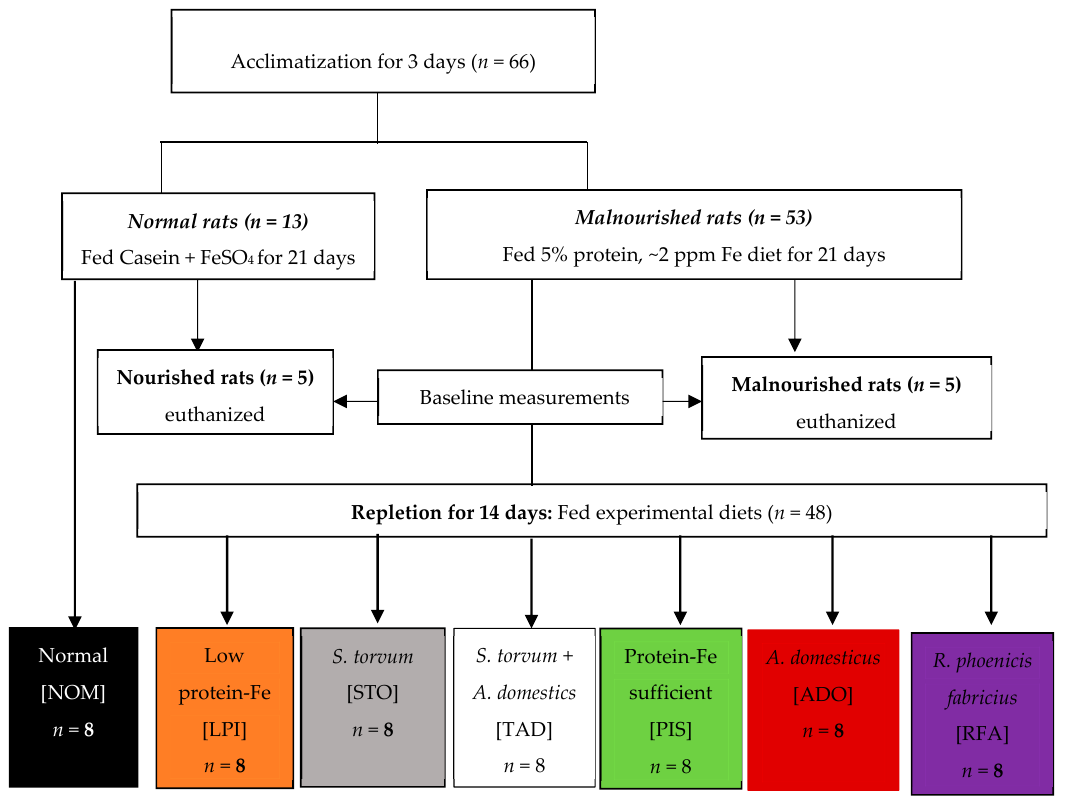
Figure 1. Study Flow Diagram.